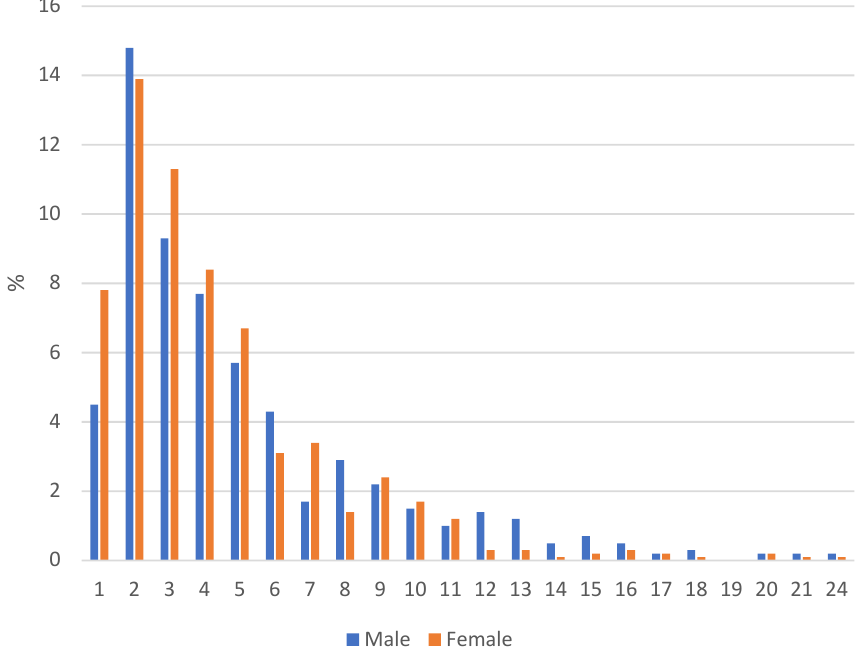
Figure 1. Frequency of total AUDIT scores in the Swedish high school student sample by gender ( n = 927), excluding the 37.5% of the sample that indicated no alcohol use at all (scored as 0). There was no significant difference detected between the proportions of male and female students with respect to engagement in alcohol use. Of the respondents, 39% of male and 36.5% of female students reported no alcohol use ( n = 227 and n = 329, respectively; p = 0.45). Male students reported more serious engagement in alcohol use (total AUDIT scores of M = 3.30 and SD = 4.02 in males and M = 2.98 and SD = 3.46 in females), but this difference was not significant ( p = 0.75; Table 1).